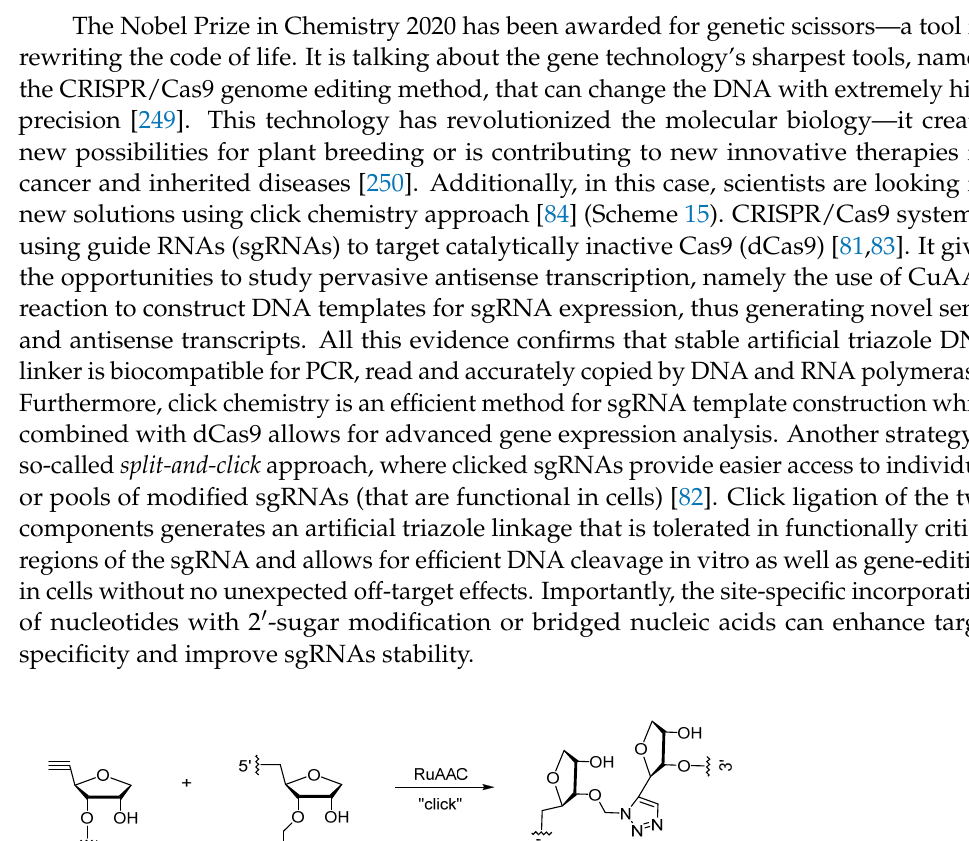
Figure 8. mRNA m 7 G 5’-cap clickable analogues.